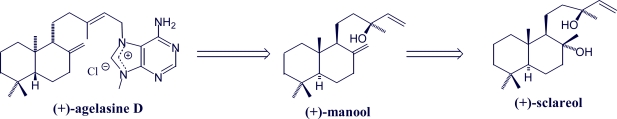
Retrosynthetic route to agelasine D [79].